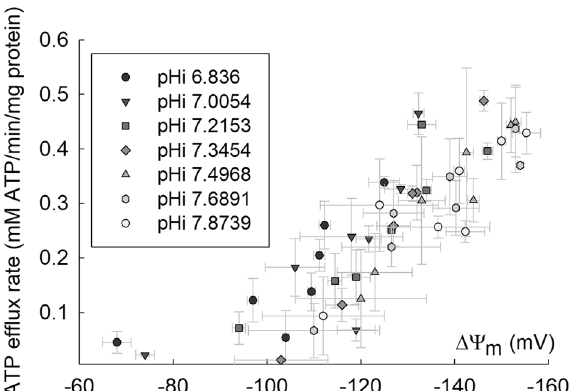
Figure 2. ATP production rate in isolated mitochondria experimentally measured as the steady-state ATP efflux rate mediated through the adenine nucleotide translocase (ANT) with mitochondrial membrane potential ( �ψ ) manipulated to various values in a range from 60 to 160 mV at various matrix pH (pHi) values in isolated rat mitochondria energized with “5 mM K-glutamate and 5 mM K-malate” in the presence of dissolved O 2 . Adapted from Chinopoulos et al. 61